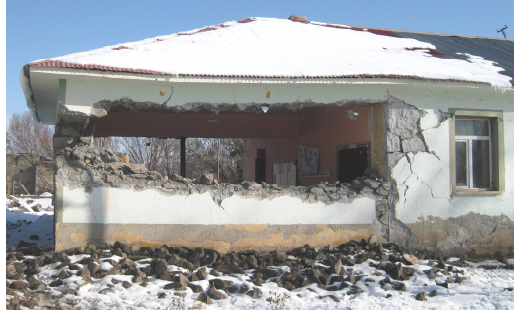
Fig. 13. Out-of-plane failure due to long unsupported wall length.